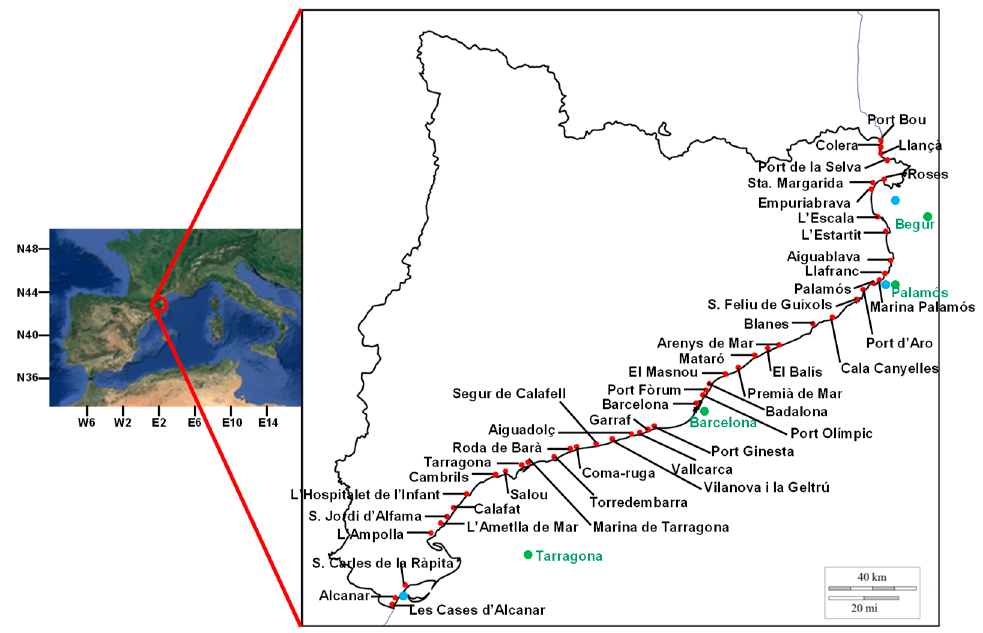
Figure 1. Location of the 47 analyzed ports, the four buoys and the three forecasting points used in the study.